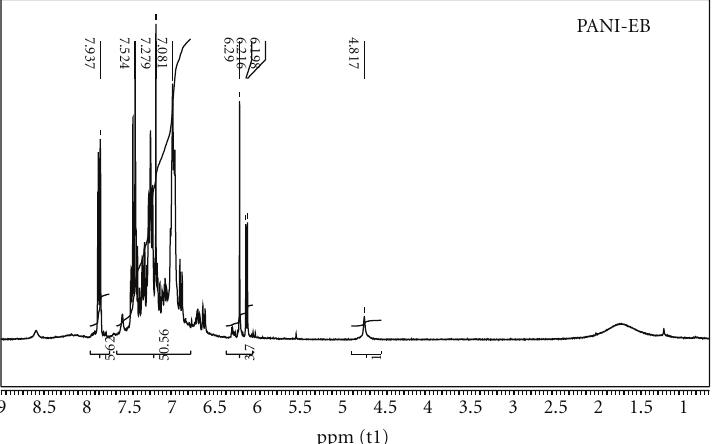
Figure 4: 1 H NMR spectrum (300MHz, CDCl 3 , tetramethylsilane (TMS) were used as the internal standard) of polyaniline (PANI-EB) obtained by the polymerization of aniline with Mag-H + initiator system in CDCl 3 at 25 ◦ C.